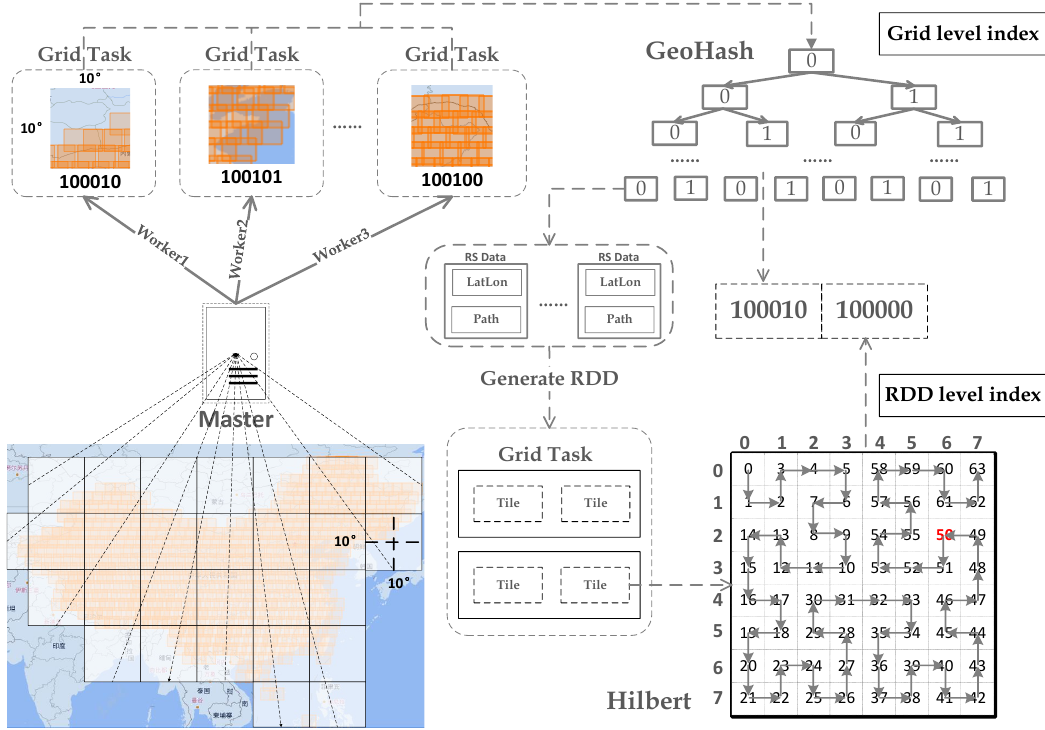
Figure 1. The experiment with remote sensing images covering China, and divide them into grids for parallel computation. The grid is divided by 10 degrees according to latitude and longitude. The master node of spark receives the result of grid division and assigns each grid to a different worker node for calculation. We build a double index for remote sensing image data, build an external index according to GeoHash encoding for the external grid, and build a Hilbert internal index for the RDD read by Spark worker